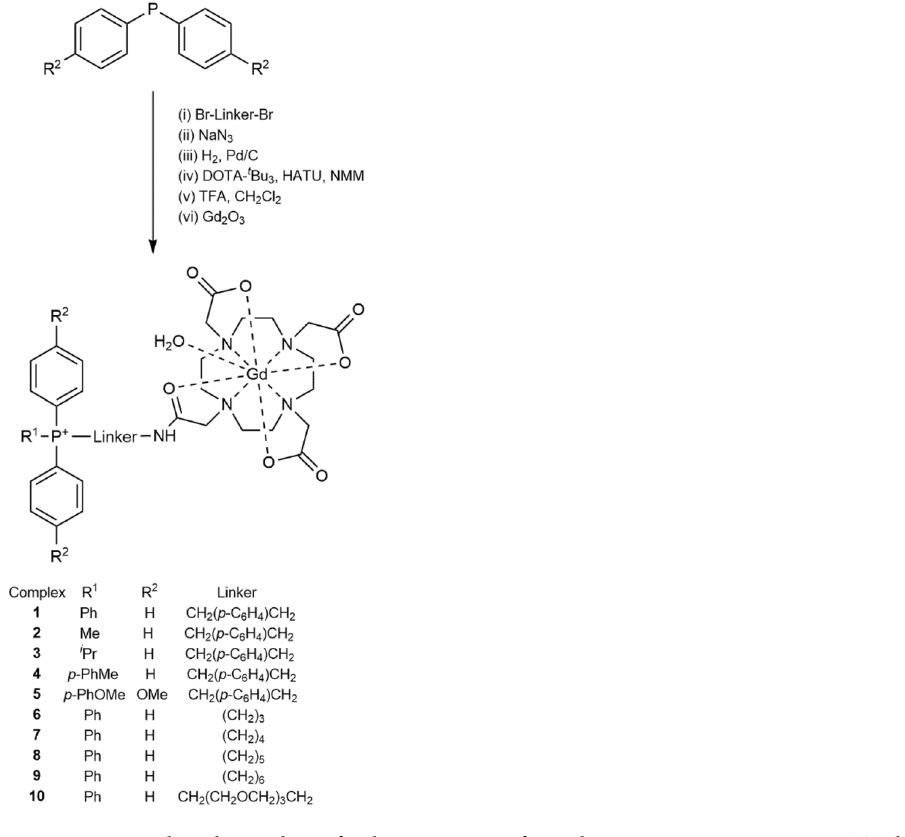
Figure 1. General synthetic scheme for the preparation of complexes 1 – 10 incorporating a DOTA chelating